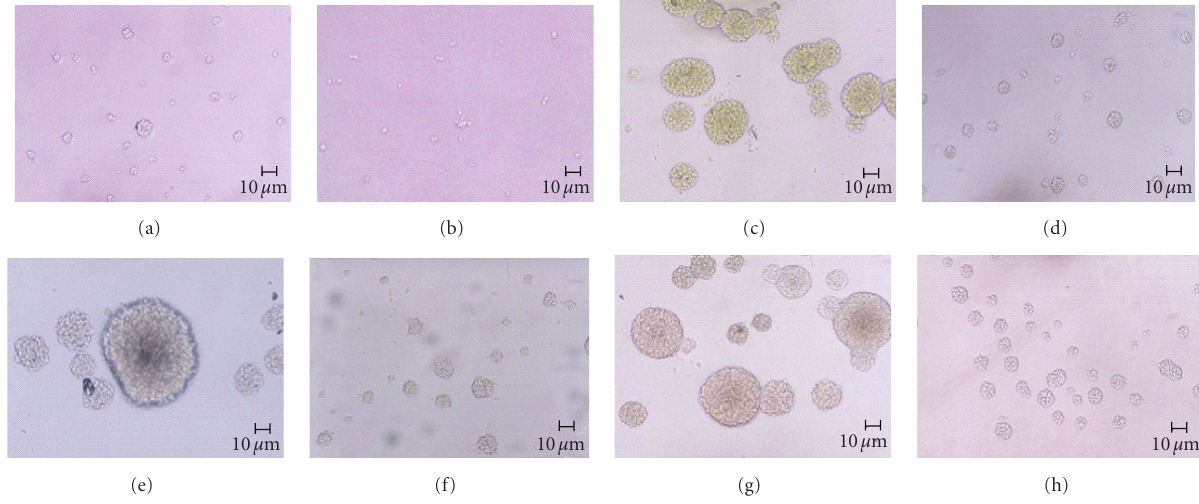
Figure 3: morphological observation of NPCs cultured in di ff erent media. (a) NPCs in control medium. (b) NPCs in FRIL medium. (c) NPCs in bFGF medium. (d) NPCs in bFGF& FRIL medium. (e) NPCs in EGF medium. (f) NPCs in EGF&FRIL medium. (g) NPCs in bFGF &EGF medium. (h) NPCs in bFGF&EGF&FRIL medium.